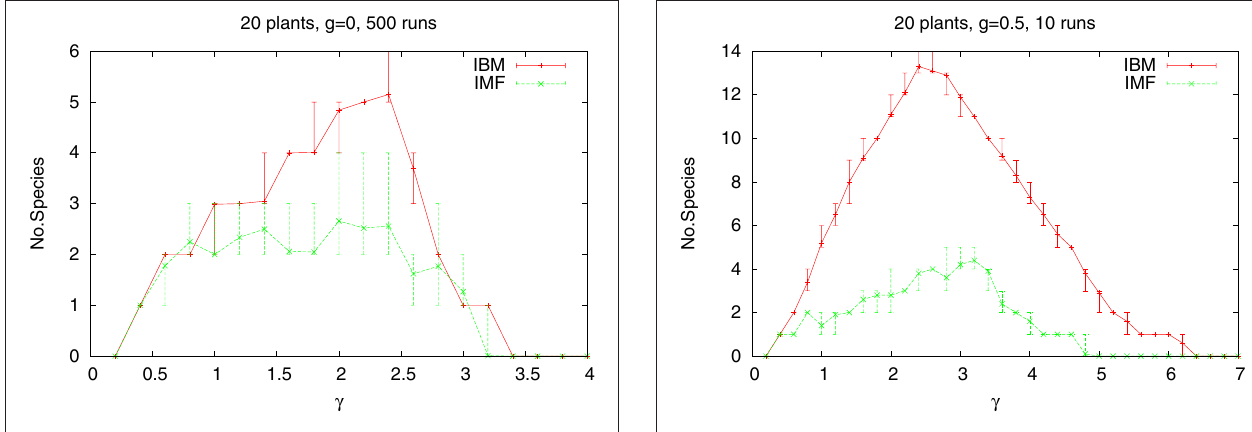
FIGURE 2 | Number of species of 20 types as a function water supply γ for the IBM and IMF approach. Homogeneous habitat. The vertical lines indicates the statistical error bars.